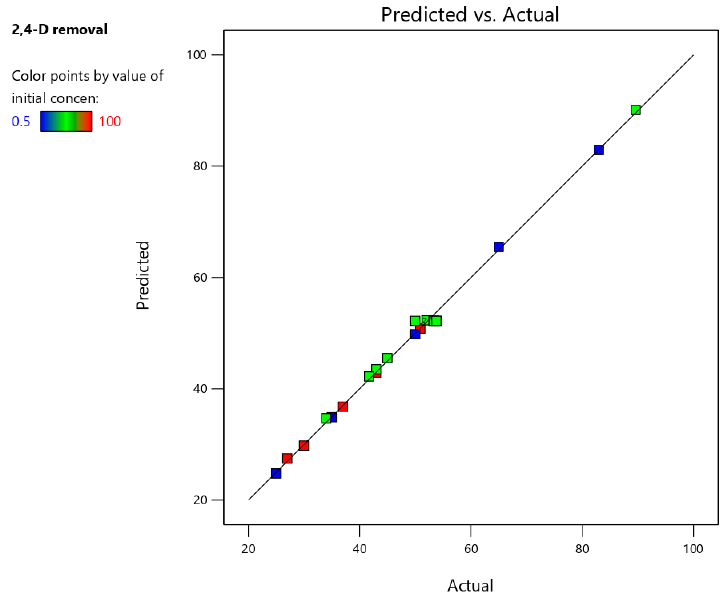
Figure 12. Plot showing 2,4-D absorption using termite mound soil projected values versus actual